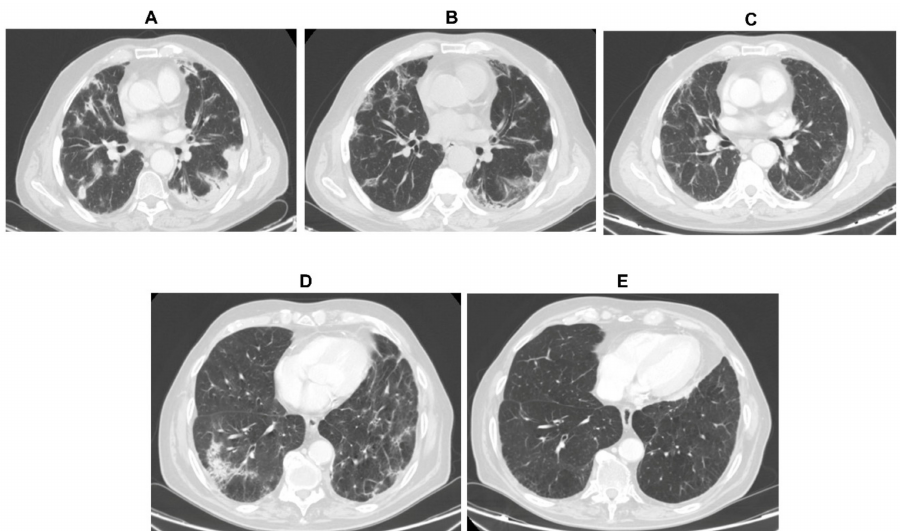
Figure 1. Computed tomography (CT) scan imaging. Panel ( A – C ): 80-year-old male with metastatic non-small-cell lung cancer (mNSCLC) showing a classical cryptogenic organized pneumonia pattern. ( A ) Axial chest CT image obtained after 10 months of treatment with nivolumab showing multiple consolidations involving both lungs. ( B ) Axial follow-up CT-image obtained 1 month later showing an improvement of pneumonitis and the presence of ground-glass opacities. ( C ) Axial follow-up CT image obtained 11 months later showing pneumonitis resolution and the presence of bilateral fibrotic alteration. Panel ( D – E ): 70-six-year-old male with mNSCLC presenting a not otherwise specified pattern of pneumonitis. ( D ) Axial chest CT image obtained 2 months after the beginning of the treatment with nivolumab showing multiple consolidations, interlobular septal thickening, subpleural reticulations. ( E ) Axial chest CT image obtained 8 months later showing a complete resolution of the